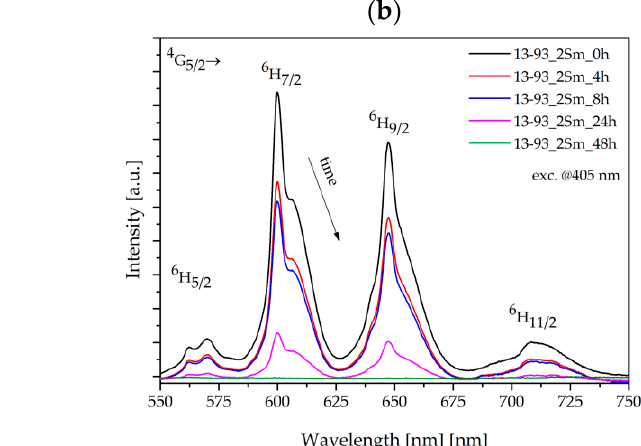
Figure 6. Characteristics of luminescence changes at 600 nm for 13 ‐ 93 bioactive glass fibers doped with 0.2 and 2 %mol Sm 2 O 3 . The coefficient of determination, R 2 , was 0.98, indicative of a good fitting for expo ‐ nential decay as obtained with the following formula: (cid:1835)(cid:4666)(cid:1872)(cid:4667) (cid:3404) (cid:1827) (cid:2869) exp (cid:4666)(cid:3398) (cid:3047) (cid:3099) (cid:4667) (2) where τ is the time constant and A 1 is the fitting constant. Differences in the intensity changes between these two groups of fibers correlated with the concentrations of samar ‐ ium ions. A higher volume of the dopant caused a slowdown in the degradation of the bioactive glass fiber. 3.4. Morphology